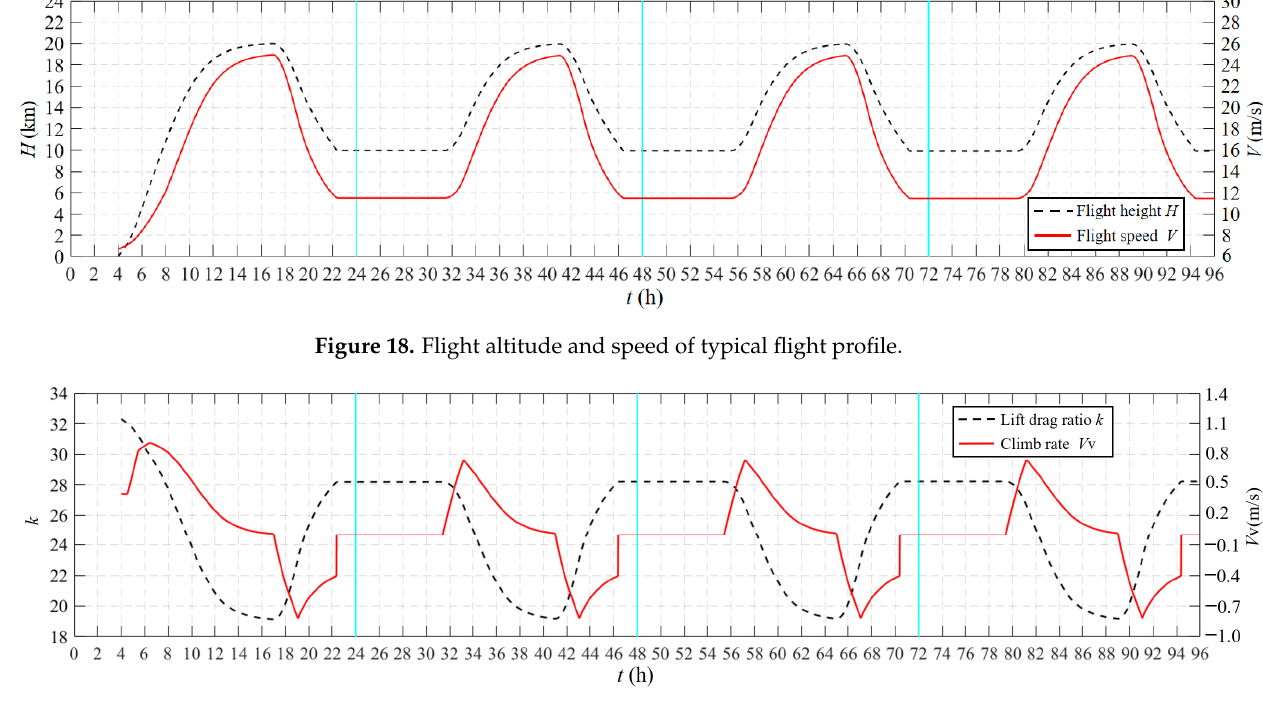
Figure 20. Secondary battery capacity and power curve of typical flight profile.